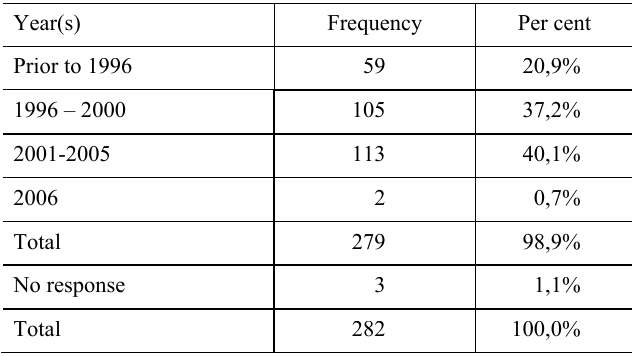
Table 4: Business inception